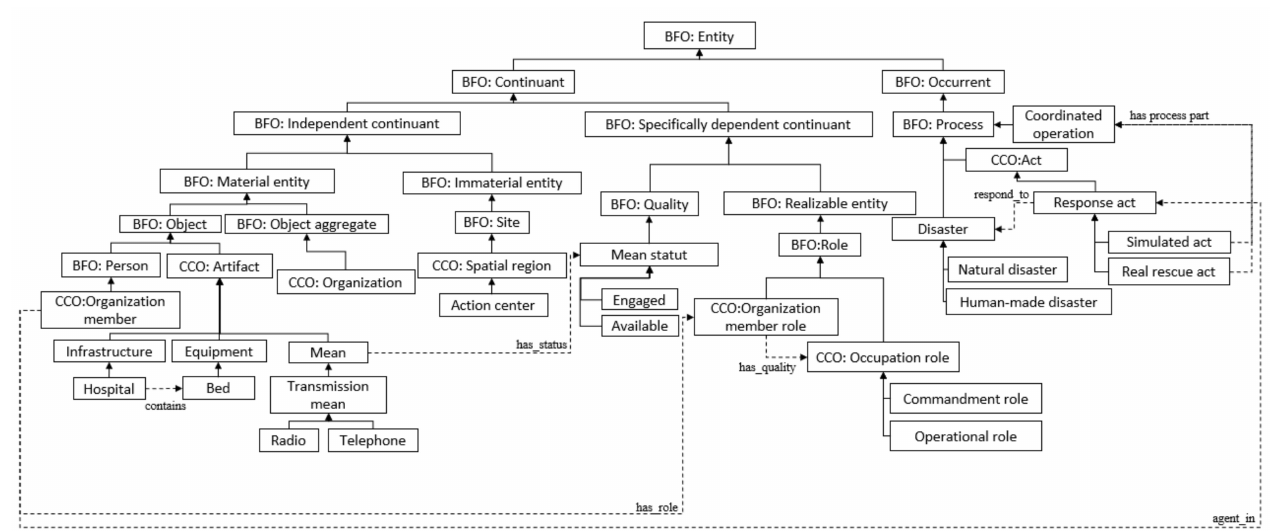
Figure 9. POLARISC Common Core (PCC) module.